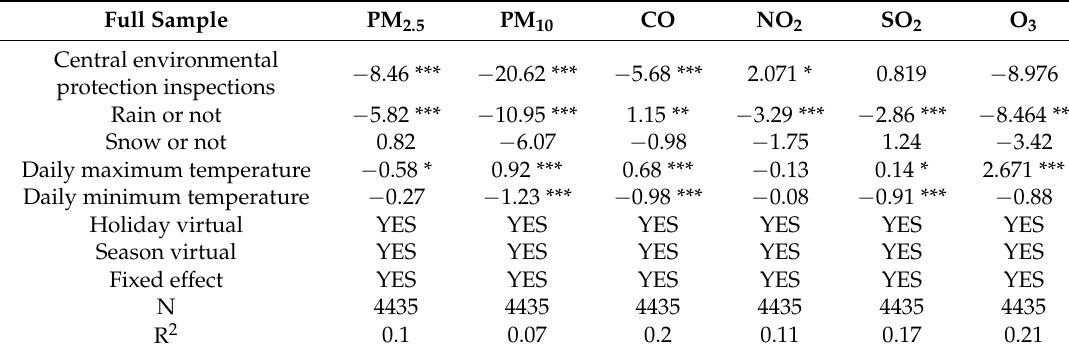
Table 4. Regression results of other